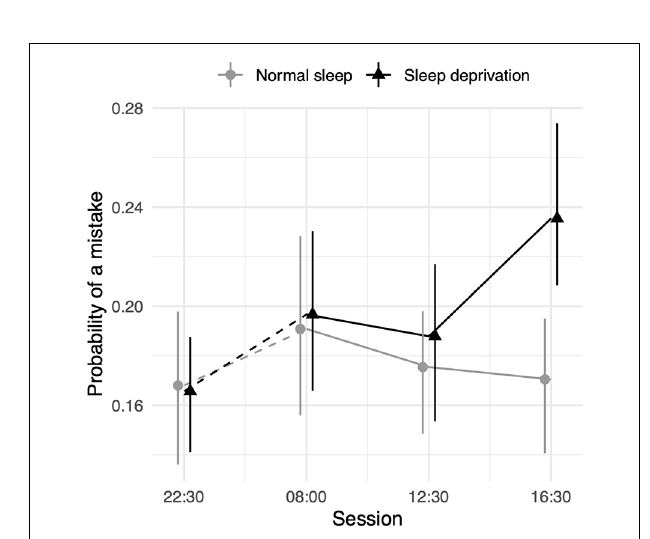
FIGURE 3 | Episodic memory test performance as measured by the probability of making an misremembering any given word depending on sleep condition and time of day. Dots represent fixed-effect estimates and error bars represent bootstrapped confidence intervals with 100 iterations. The dotted line between 22:30 h and 08:00 h represents the night of total sleep deprivation for the sleep-deprivation group. (22:30 h), outperformed intercept-only models. Participants were found to have higher odds of making errors at 16:30 h relative to performance at 22:30 h. No other significant time-of-day effects were observed. The results of these three models can be found in Table 5 and the model predictions of these three models are presented in Figure 5 .